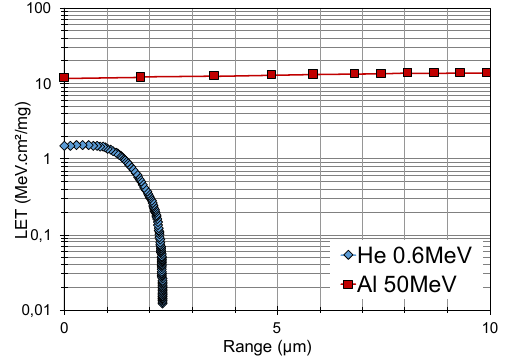
Fig. 3. LET versus range for the aluminum and alpha